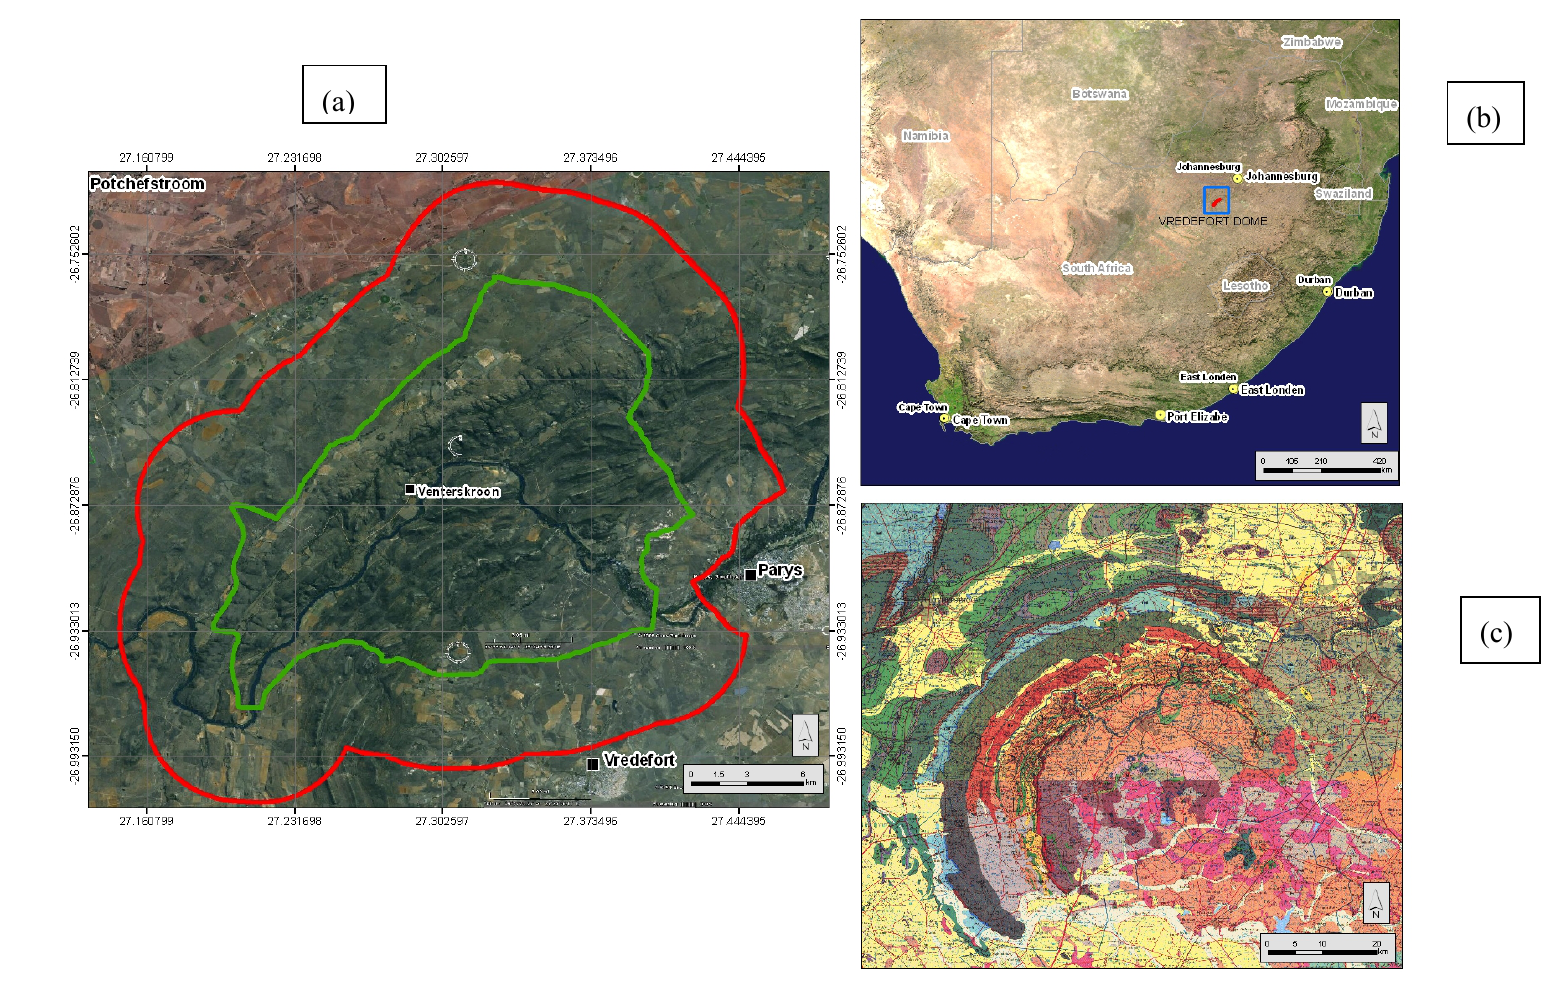
Figure 1. The Vredefort Dome World Heritage Site: Local setting (a), its locality within South Africa (b) and the impacted geology (c) (Note—the three images in Figure 1 are for orientation purposes only. For a detailed geological map, refer to Figure